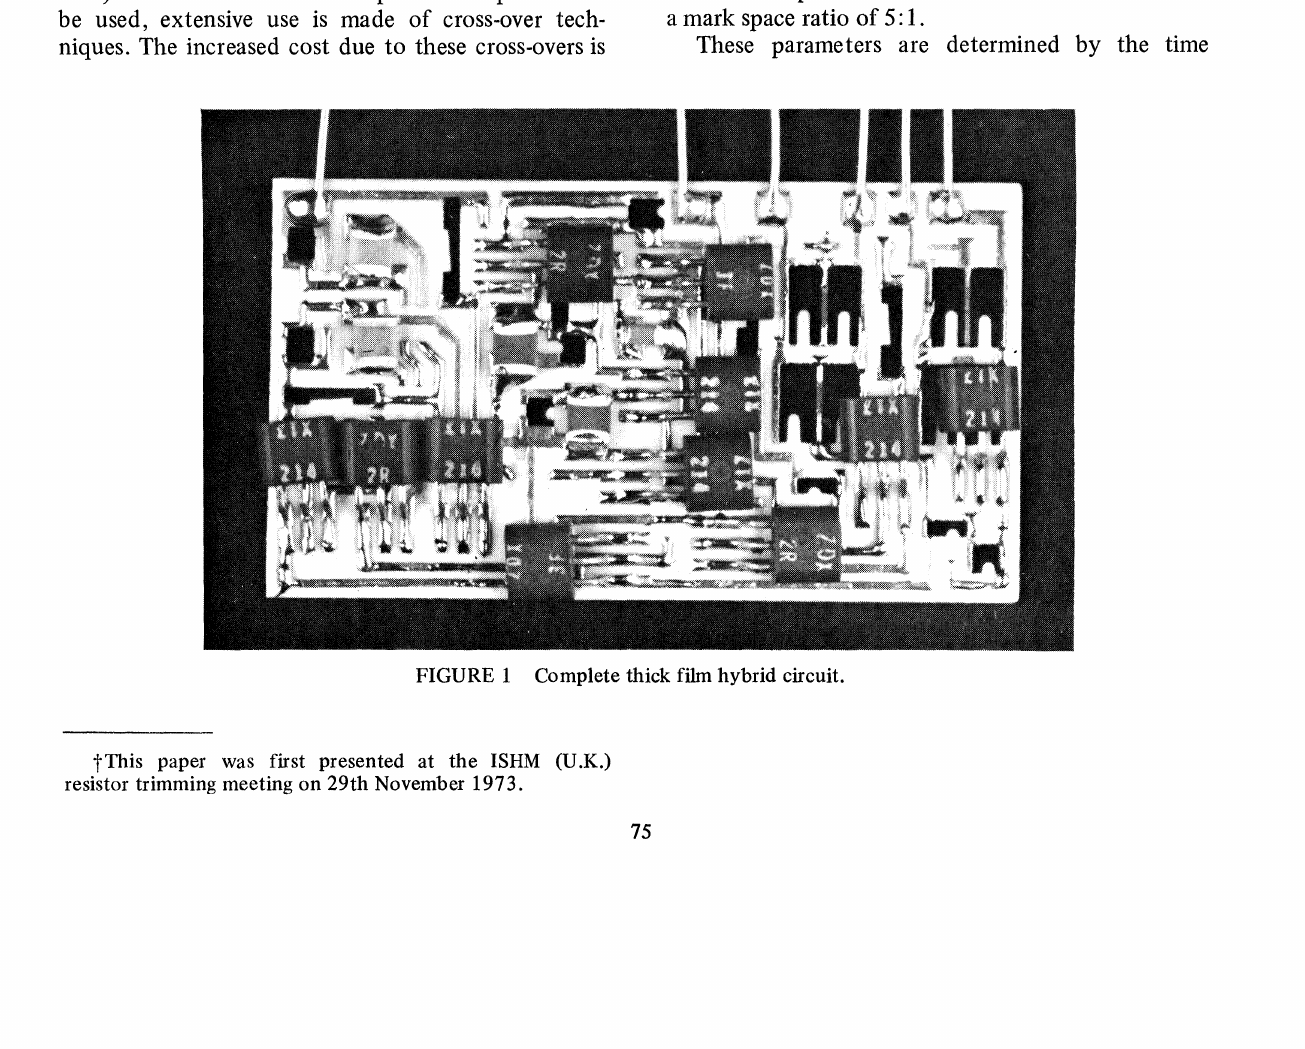
FIGURE Complete thick film hybrid